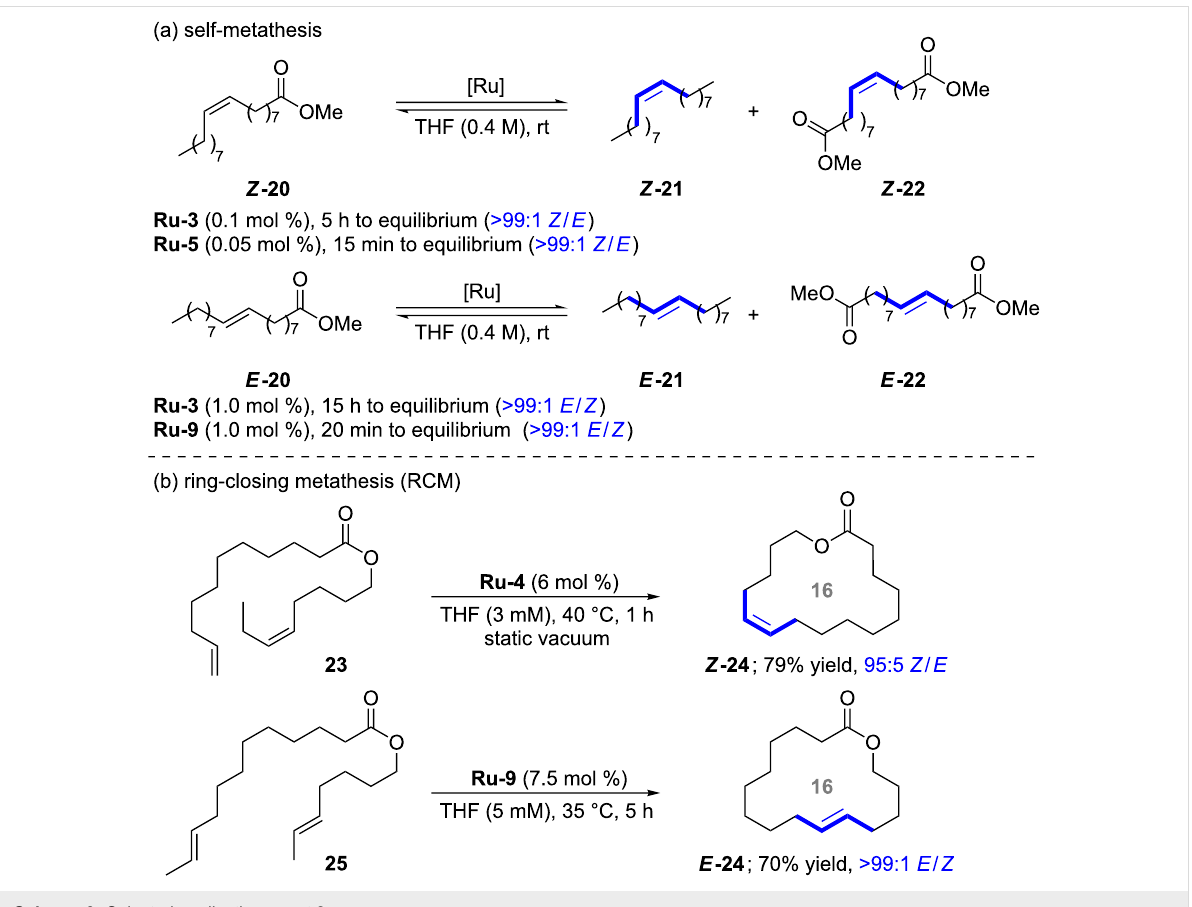
Scheme 3: Selected applications, part